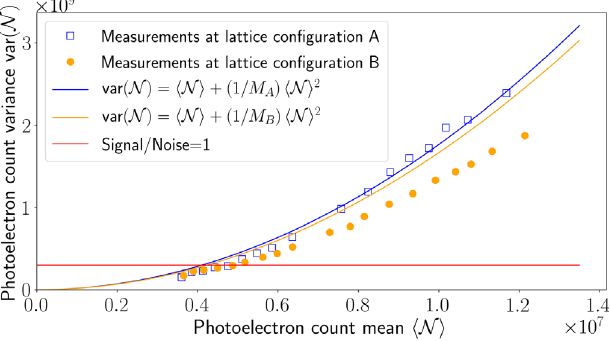
FIG. 3. Experimental data from Ref. [1] for wiggler radiation (points) and predictions made by our calculation (solid curves). The noise variance ( 3 × 10 8 ) has been subtracted from the